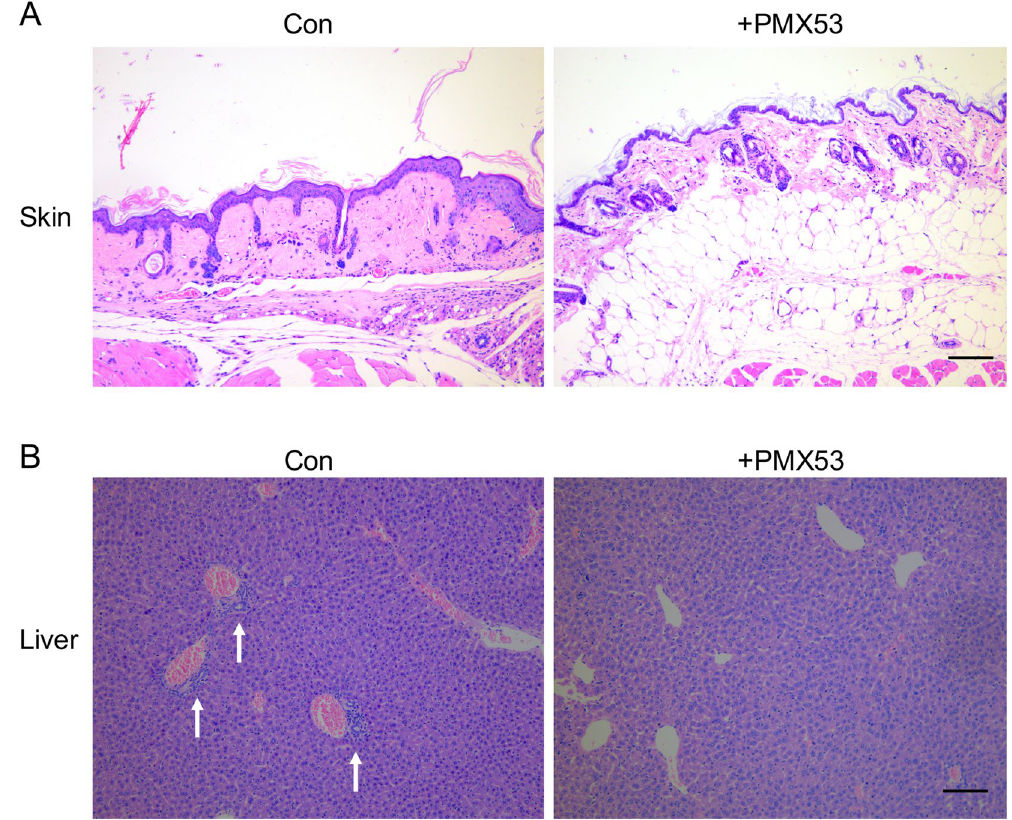
Figure 4. PMX53 treatment attenuated the pathological damage of cGVHD mice. ( A ) Skin histologic examination by HE staining showed that the cGVHD mice subjected to PBS treatment presented with damaged skin, including thickening in the epithelial layer, a loss of hair follicles, a lack of subdermal fat and heavy collagen deposition. However, the PMX53 treatment group exhibited a relative well-organized structure of skin compared to control cGVHD mice, including a reduced thickness of epithelial layer, more hair follicles, increased thickness of subdermal fat layer and decreased collagen deposition. ( B ) Liver histologic examination revealed clear perivascular infiltration surrounding the bile duct (white arrows) in the cGVHD mice, whereas few infiltrated cells were observed in the PMX53 treatment group. At least five mice were used in each group (N = 5). Scale bar: 200 μ